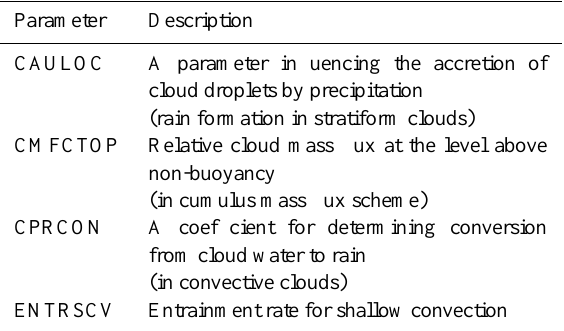
Table 1. The considered sub-set of ECHAM5 closure